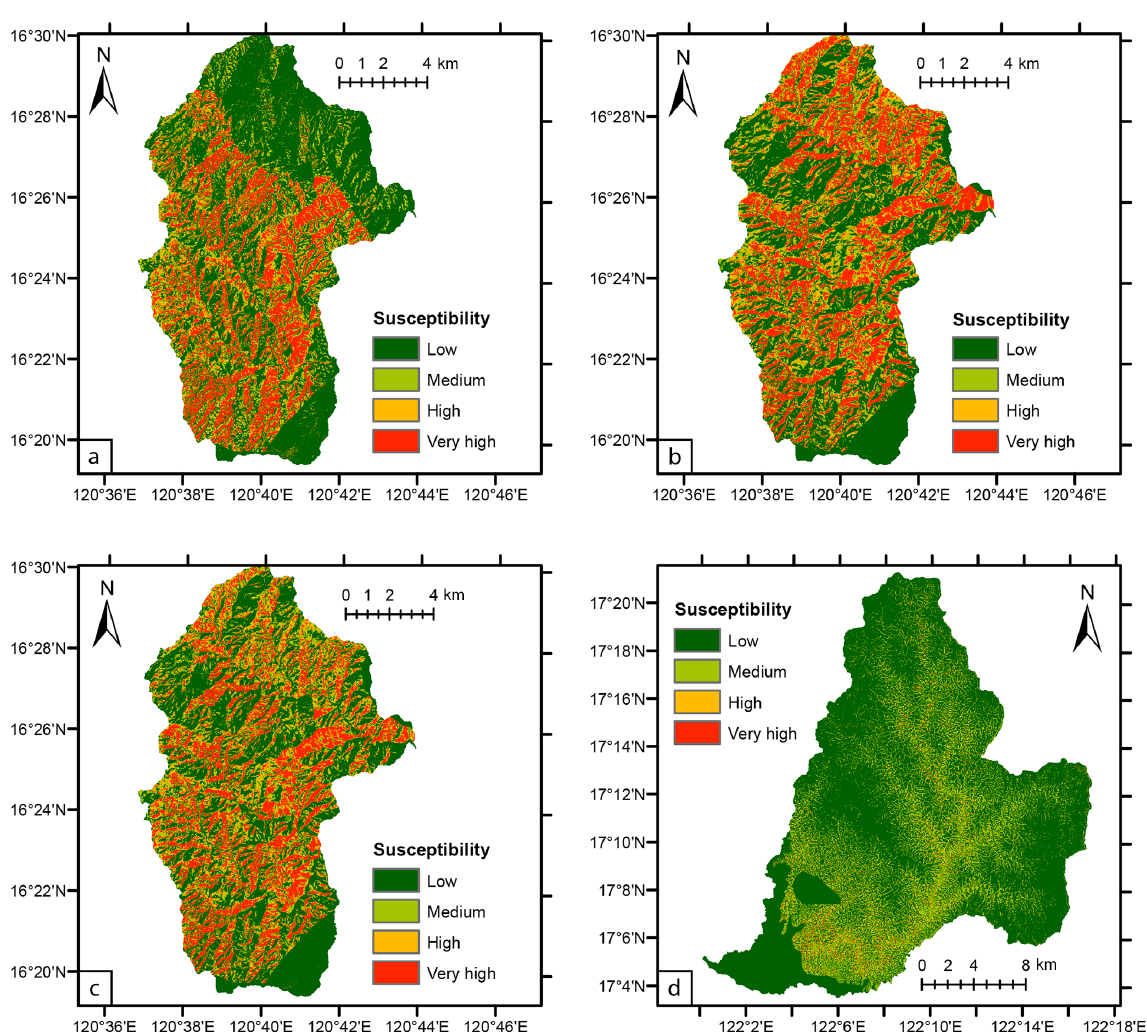
Figure 4. The final susceptibility maps produced from (a) the 2018 landslide inventory, (b) the 2009 landslide inventory, (c) the combined 2018 and 2009 inventories, and (d) the 2019 inventory. Here (a) – (c) correspond to the Itogon region and (d) to the Abuan